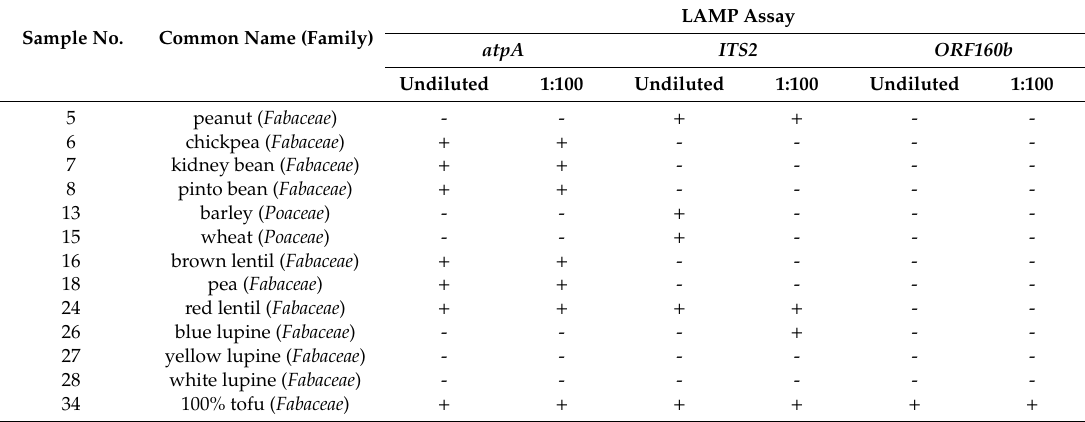
Table 5. Results of initial specificity assessment of the LAMP assays atpA , ITS2 , and ORF160b with closely related species and species commonly used as food ingredients. The DNA of potential cross-reactants was analyzed undiluted and 100-fold diluted, tofu served as a positive control ( + : positive reaction; -: negative